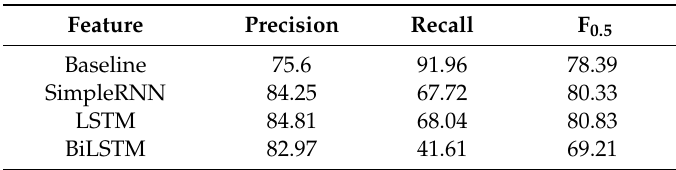
Table 8. QALB Test